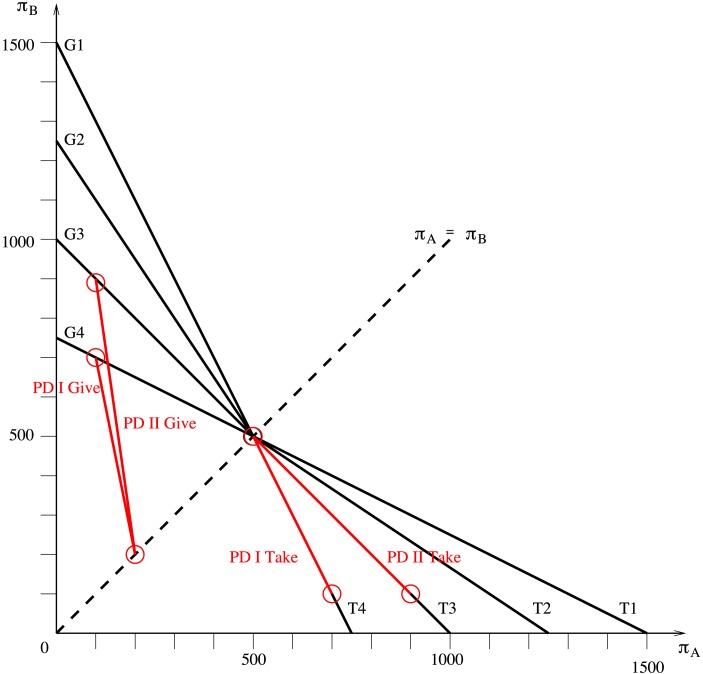
Budget lines in modified dictator and sequential prisoner’s dilemma games.